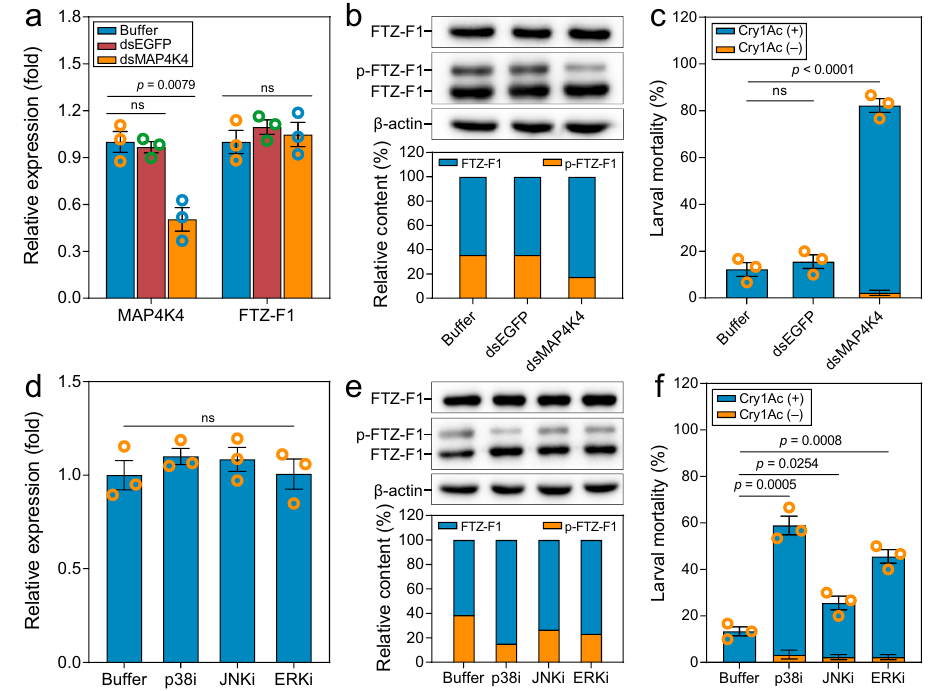
Fig. 6 | MAPK cascades regulate the in vivo phosphorylation level of FTZ-F1. a – c Effect of silencing MAP4K4 gene on FTZ-F1 mRNA expression ( a ), protein level and degree of phosphorylation ( b ), and larval mortality ( c ) in the resistant strain NIL-R. d – f Effect of speci fi c inhibitors of p38, ERK, or JNK on FTZ-F1 mRNA expression( d ),proteinlevelanddegreeofphosphorylation( e ),andlarvalmortality ( f ) in the resistant strain NIL-R. Relative mRNA expression levels ( a , d ) were quan- titated and normalized to the expression level of the RPL32 gene, the value for the